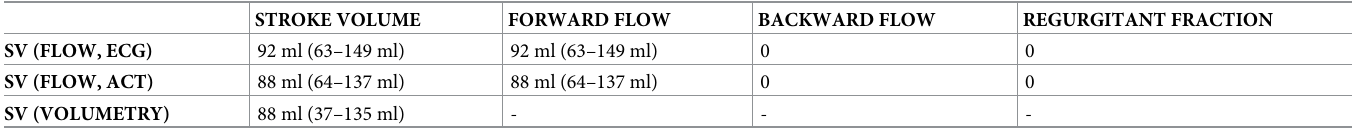
Table 4. Flow measurements with ECG and ACT triggering.